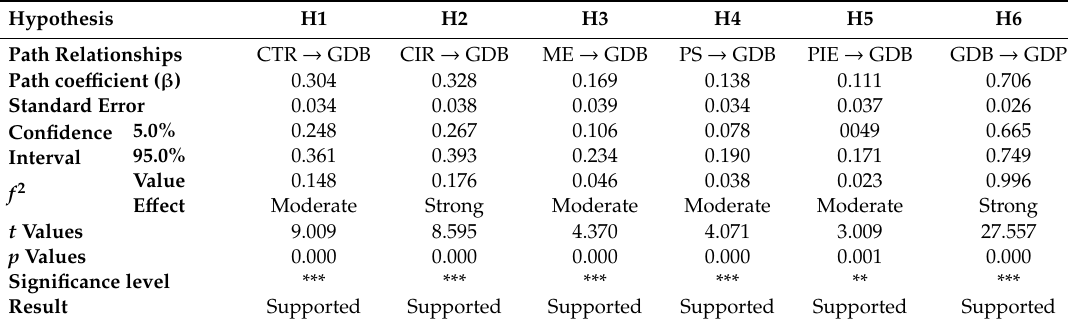
Table 5. Path coe ffi cients and confidence